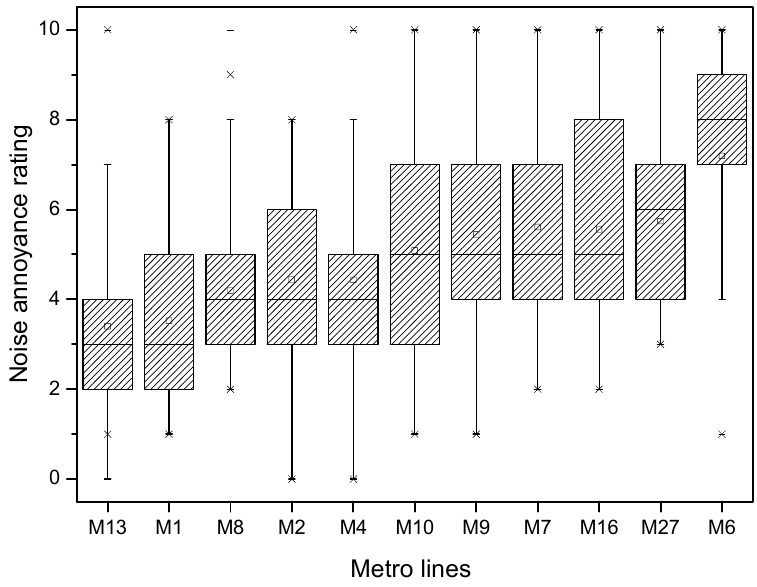
Figure 4. Subjective annoyance ratings of interior noises for different metro lines.